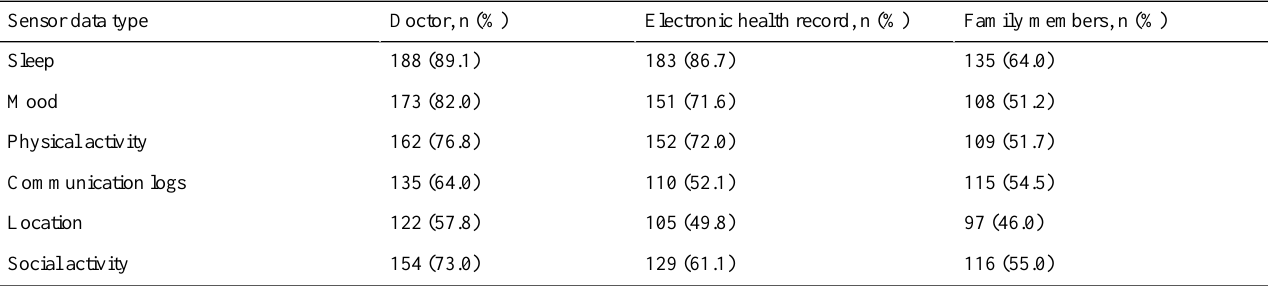
Table 2. Participants’ comfort level sharing various sensor data with different recipients. The values indicate participants who were comfortable with sharing data.